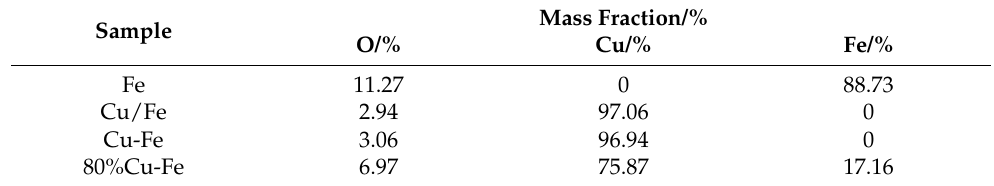
Table 4. Surface composition analysis of different materials after potentiodynamic polarization in 3.5% NaCl